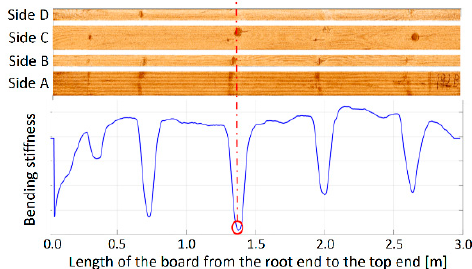
Figure 1. Prediction of critical selections.